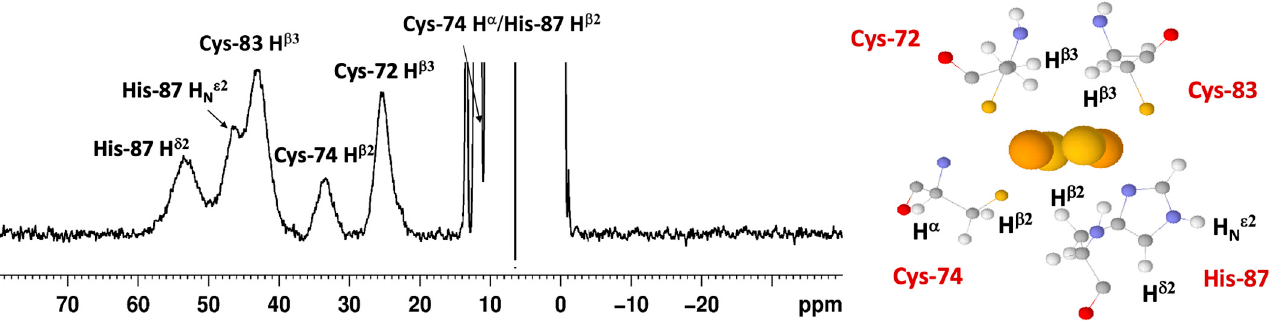
Figure 4. Paramagnetic 1 H 1D spectra of oxidized [2Fe-2S] 2+ mitoNEET at 600 MHz, 283 K [75].